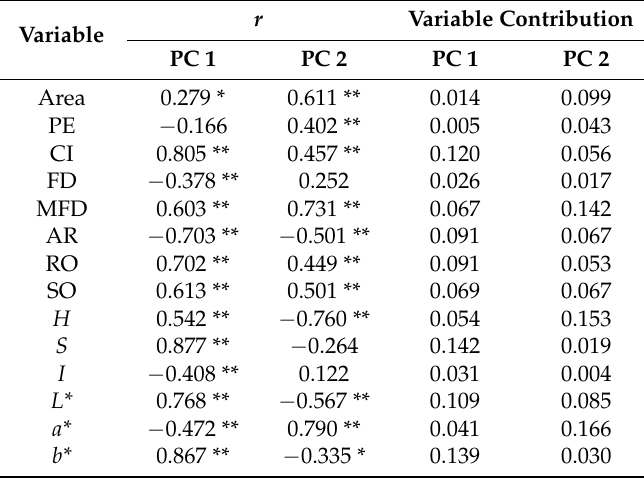
Table 6. Correlation coefficients ( r) between a variable and a principal component (PC) and the contribution of each variable to the